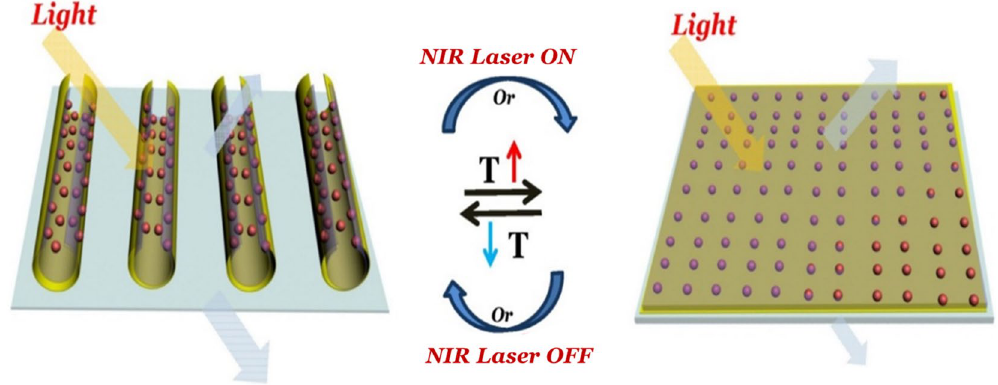
Figure 8. Schematic illustration of photo-responsive properties of INCP film induced by temperature or NIR